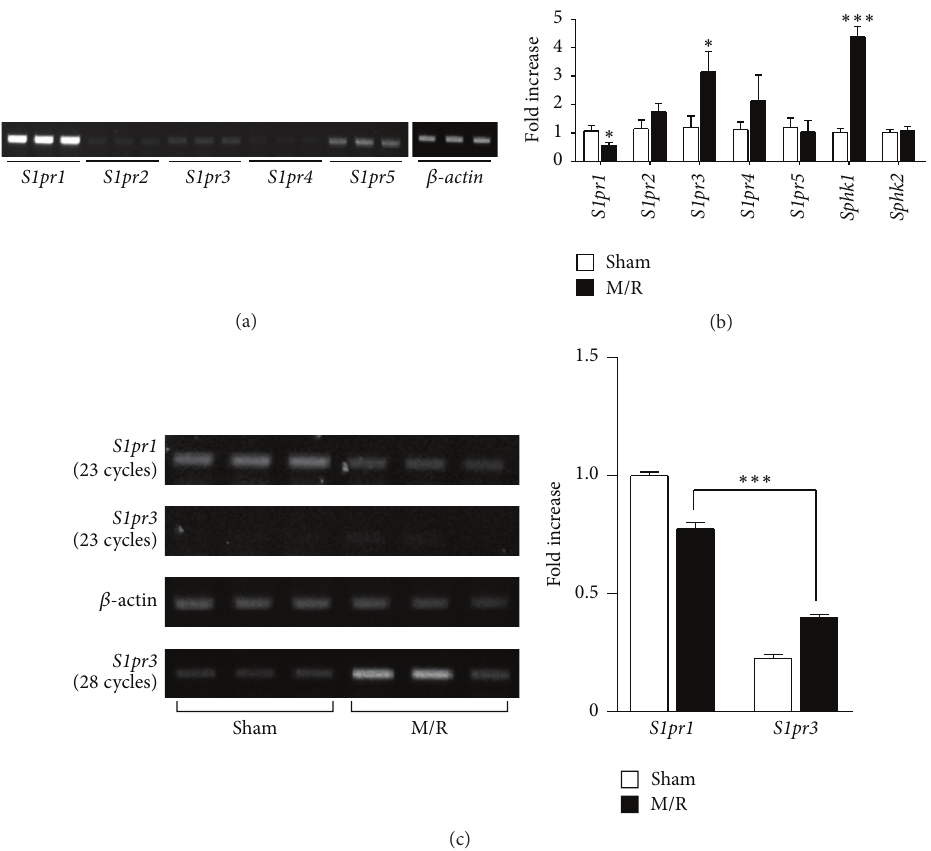
Figure 2: mRNA expression levels of S1P receptors and S1P-producing enzymes are altered in an M/R-challenged brain. (a) Normal brains were used to determine mRNA expression levels of S1P receptors ( S1pr1 , S1pr2 , S1pr3 , S1pr4 , and S1pr5 ) and SPHKs ( Sphk1 and Sphk2 ) based on semiquantitative RT-PCR analysis (28 cycles for all targets). (b, c) Mice were challenged by 90 min occlusion followed by 22 h reperfusion. (b) Brain samples were used to determine changes of S1P receptors and SPHKs based on qRT-PCR analysis. ∗ 𝑃 < 0.05 and ∗∗∗ 𝑃 < 0.001 , compared with the sham group ( 𝑡 -test), 𝑛 = 5 per group. (c) Brains from sham and M/R-challenged mice were used to determine mRNA expression levels of S1P 1 and S1P 3 by semiquantitative RT-PCR analysis. Band intensity (bar graph) was calculated as fold increase relative to S1pr1 level of sham groups after normalization to 𝛽 -actin. ∗∗∗ 𝑃 < 0.001 , compared with S1pr1 level of M/R group (Newman-Keuls test), 𝑛 = 3 per